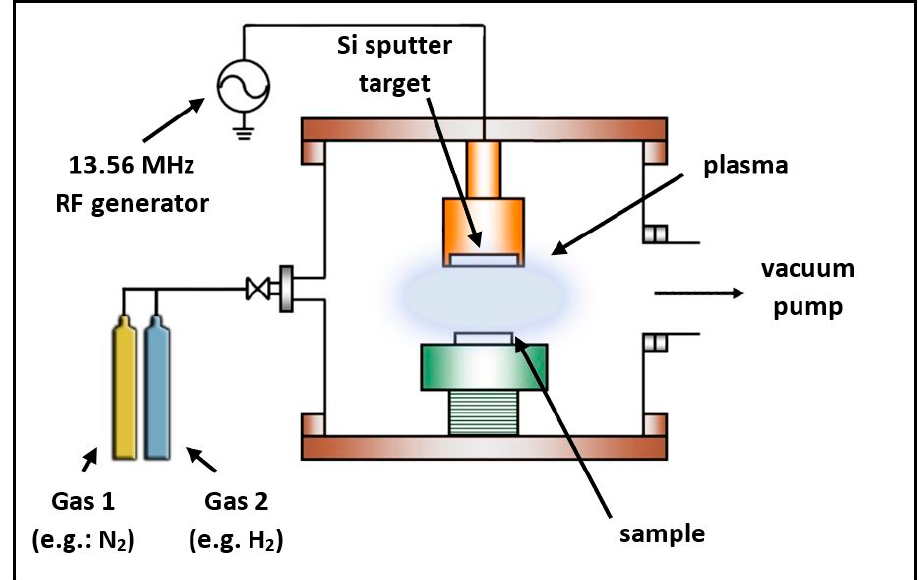
Figure 2. Schematic drawing of an RF sputtering chamber.